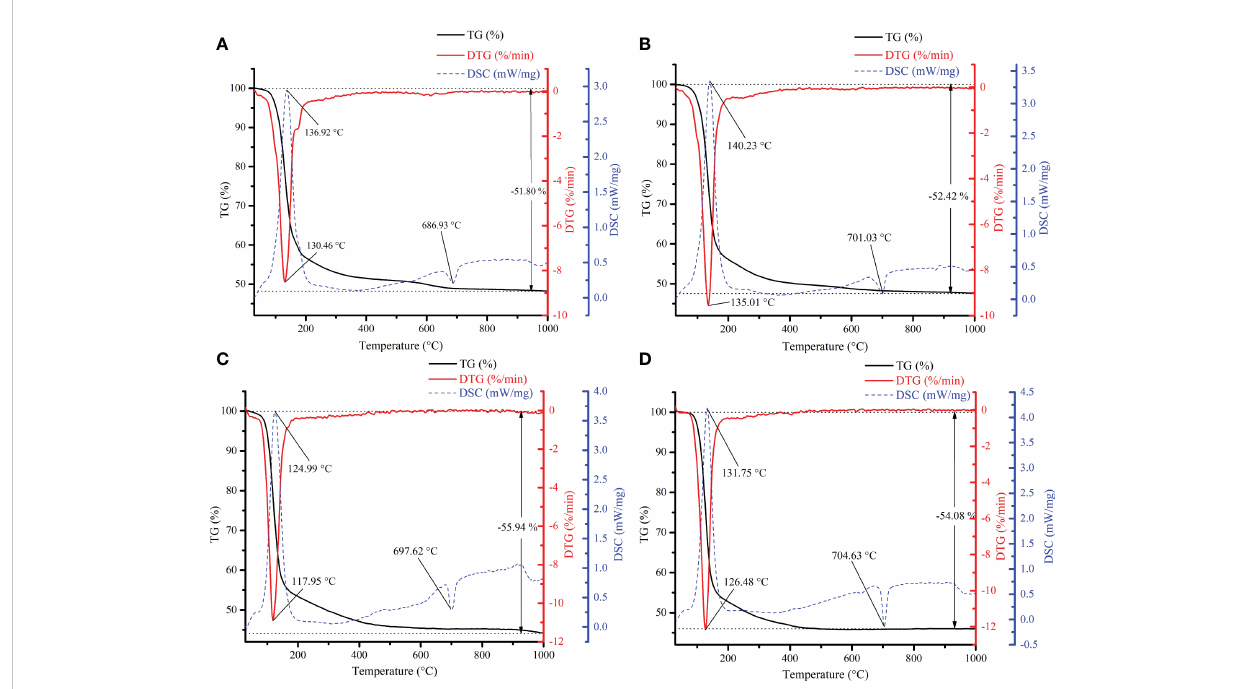
FIGURE 6 Thermogravimetric, differential thermal gravity and differential scanning calorimetry (TG – DTG) analysis of mineral crystals. (A) , the mineral crystals induced by A. alteriprofundi HHU 13199 T in TSA medium; (B) , the mineral crystals induced by A. alterisediminis N102 T in TSA medium; (C) , the struvite obtained in TSB medium with ammonia; (D) , the commercial struvite